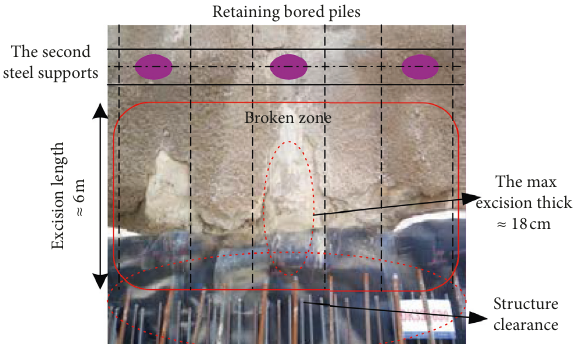
Figure 2: Clearance intrusion and excision of pile body.